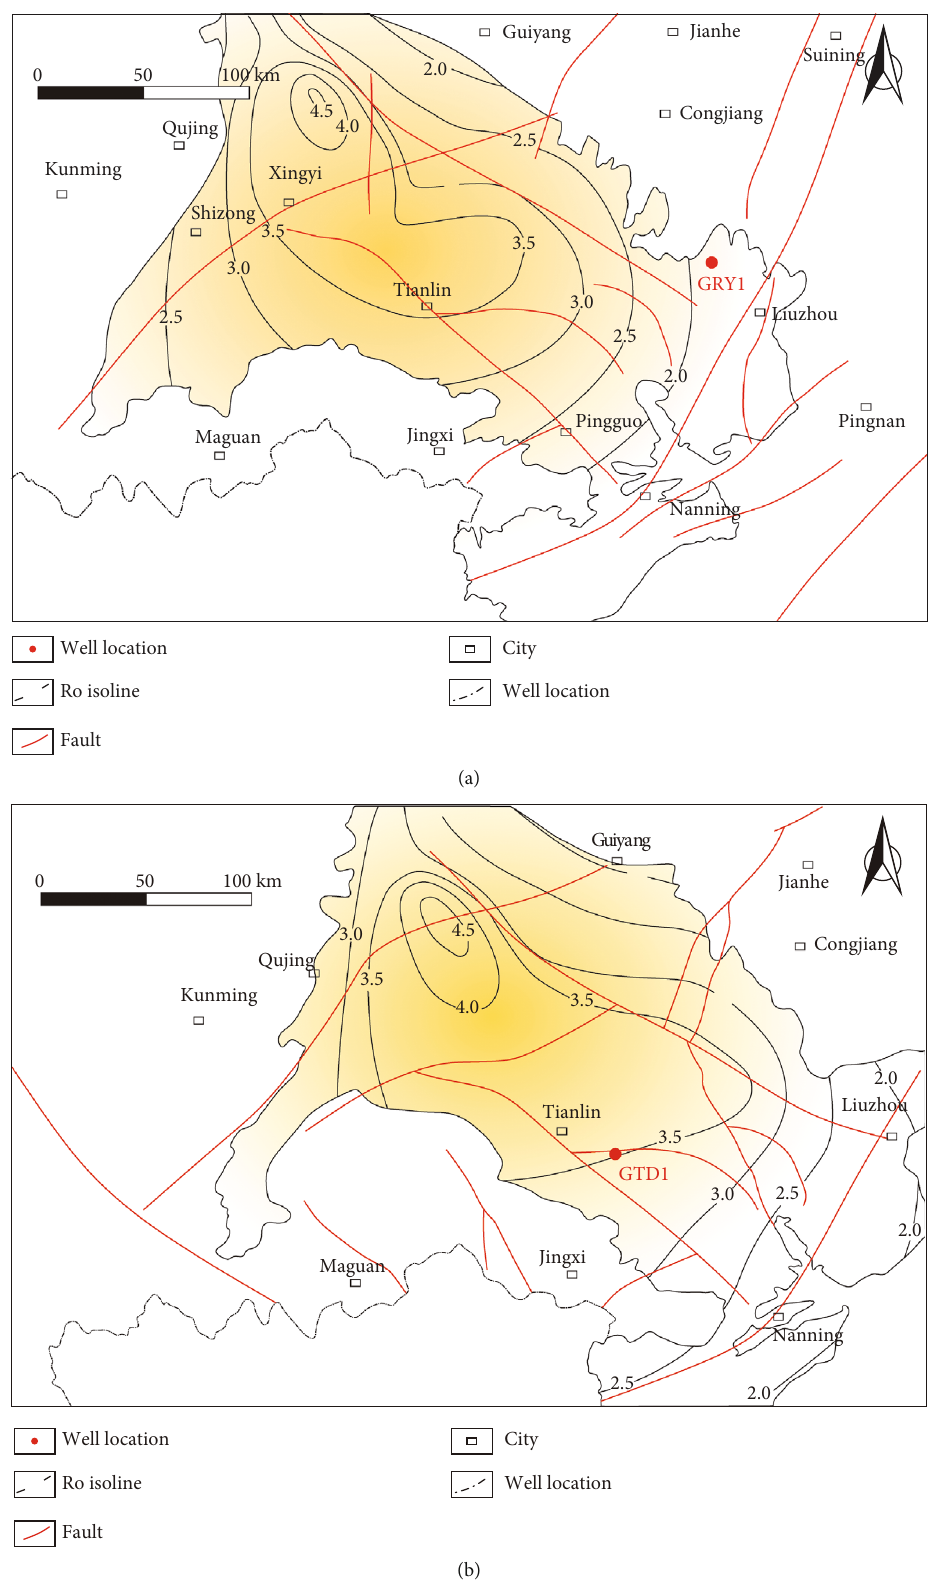
Figure 12: (a) Ro contour map of organic rich shale of Lower Carboniferous Luzhai formation; (b) Ro contour map of organic rich shale of Middle Devonian Luofu